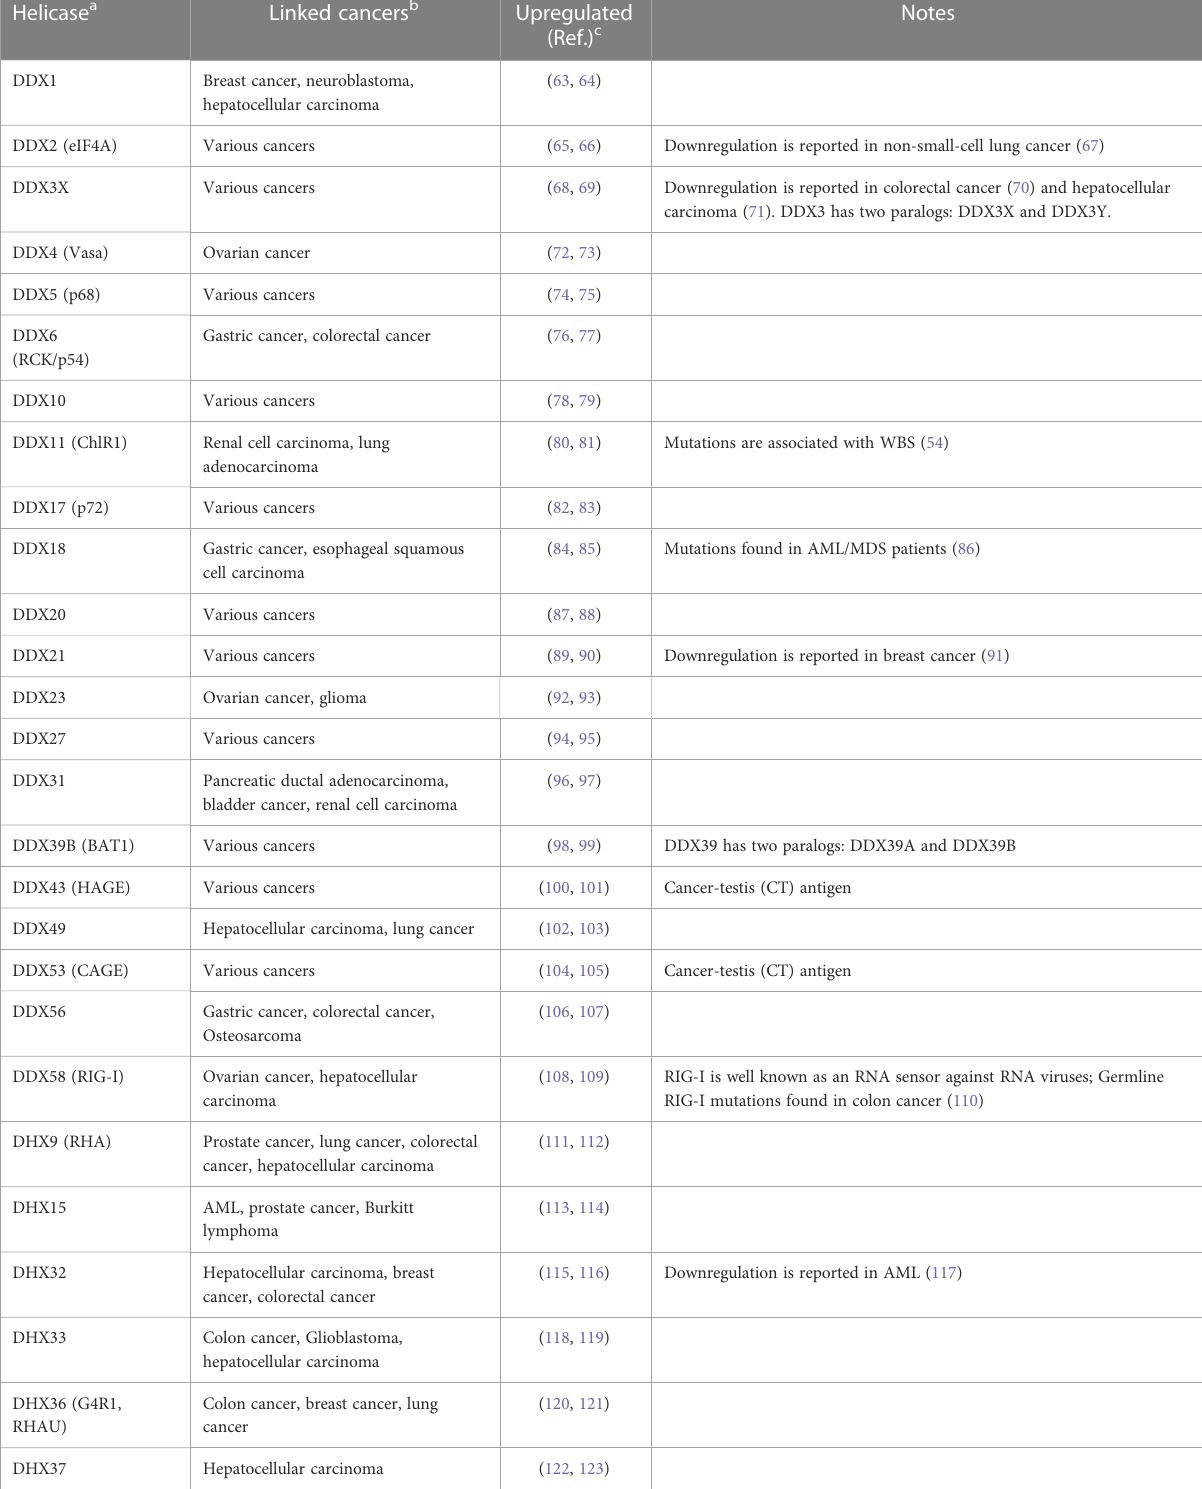
TABLE 1 Abnormal expression of DEAD/H-box helicases in